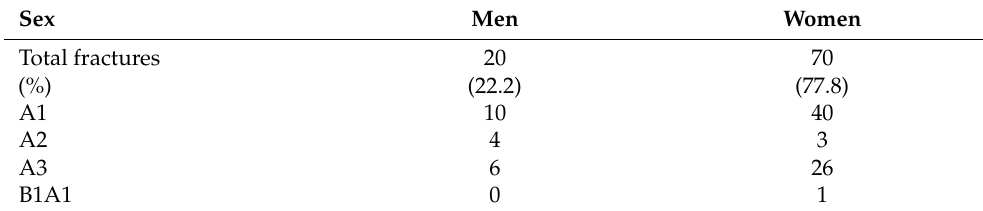
Table 2. Fracture distribution according to sex.